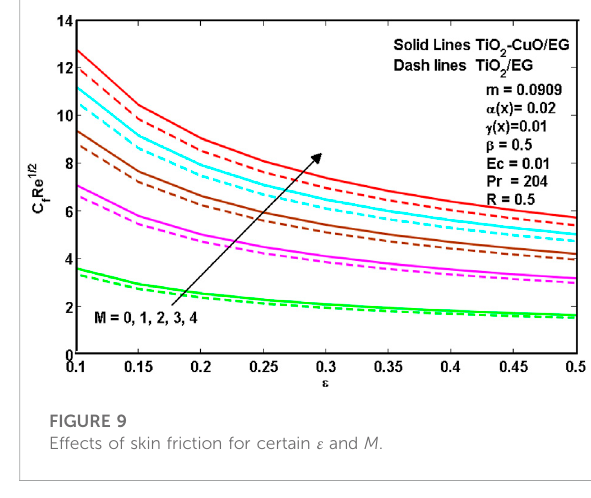
FIGURE 9 Effects of skin friction for certain ε and M .